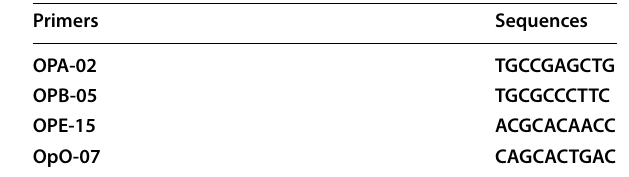
Table 2 The RAPD primers and their sequences used for the genetic fidelity